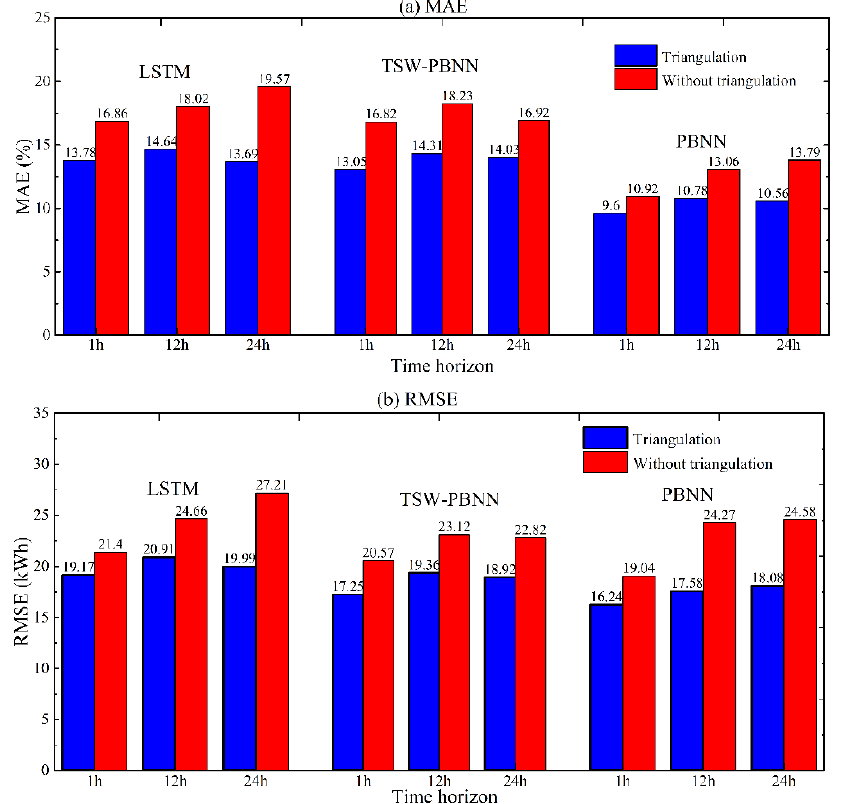
Figure 15. Comparison of prediction errors after preprocessing with triangulation and without triangulation.